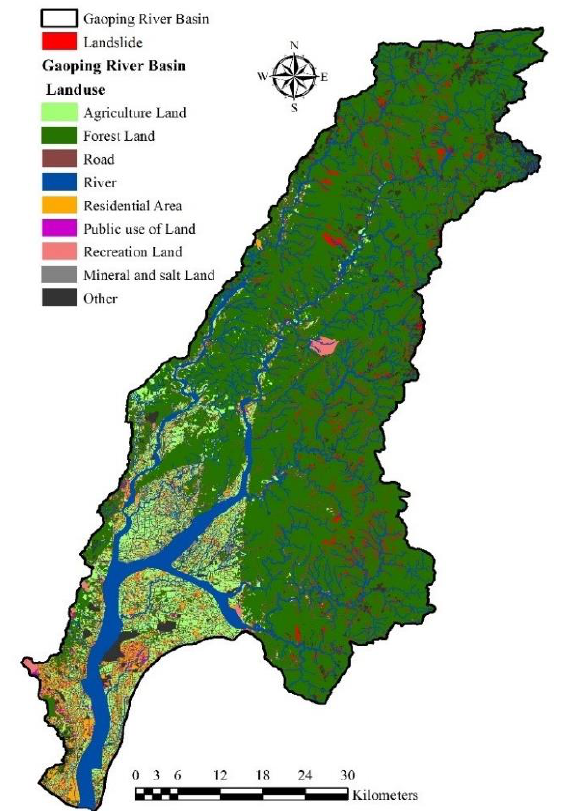
Figure 7. Digital land use map of the Gaoping River watershed [28].